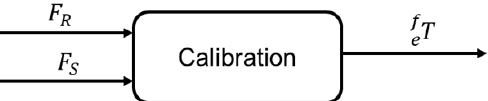
Figure 5. Force sensor calibration.